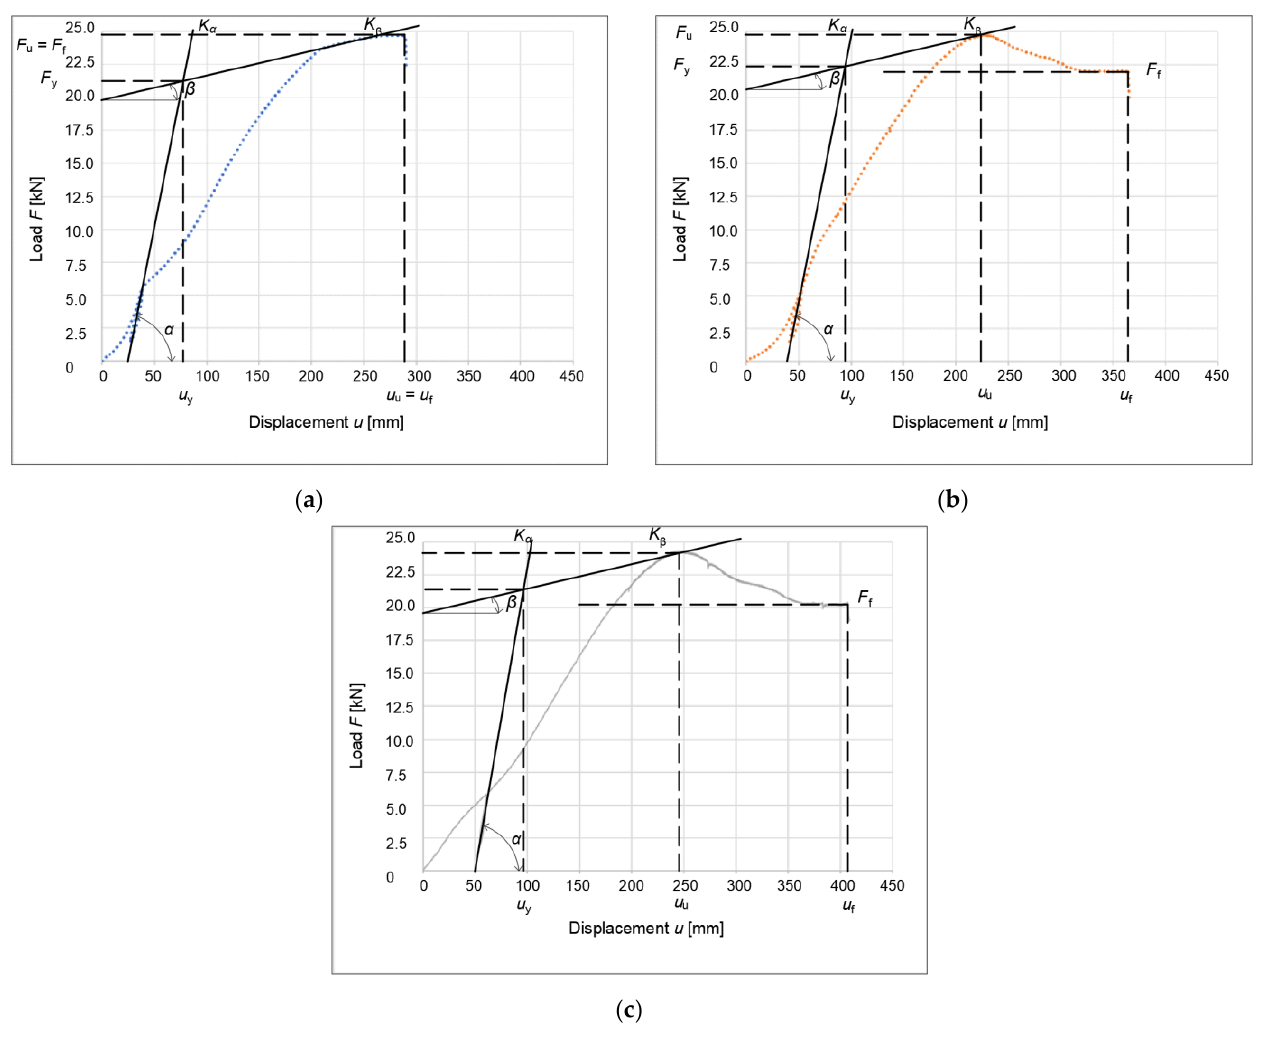
Figure 18. Graphical representation of the yield strength of a connection formed with screws according to EN 12512: ( a ) unreinforced specimen; ( b ) reinforced partitions; and ( c ) reinforced rung and struts (stands). Table 7. Ductility classification according to standard and research